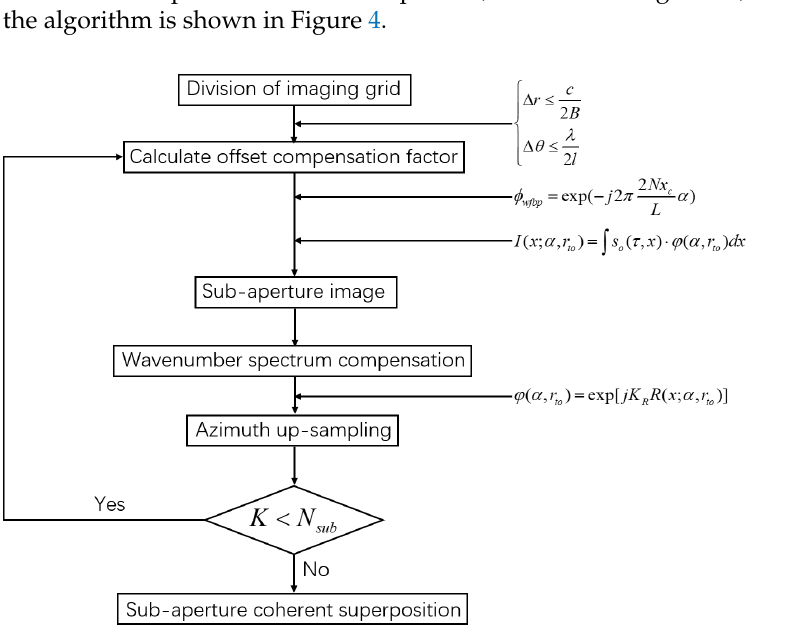
Figure 4. Flowchart of the WFBP